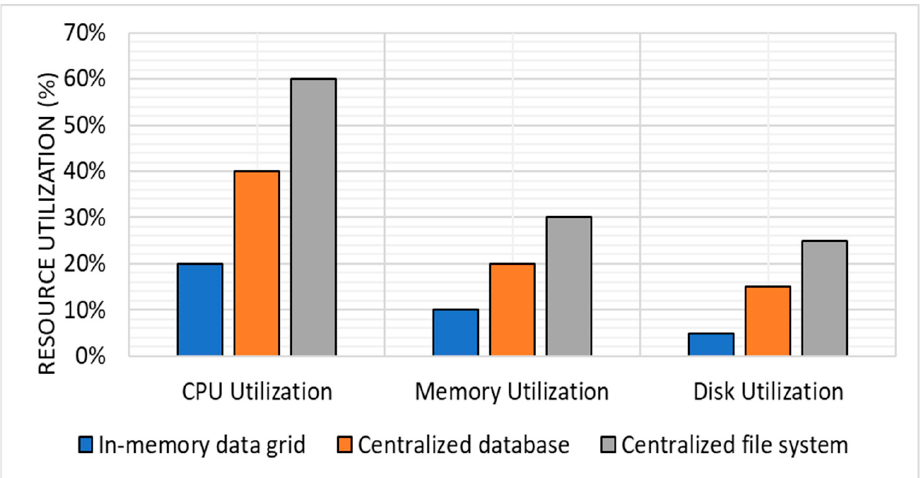
Figure 2. The average of Replication for the resource utilization.